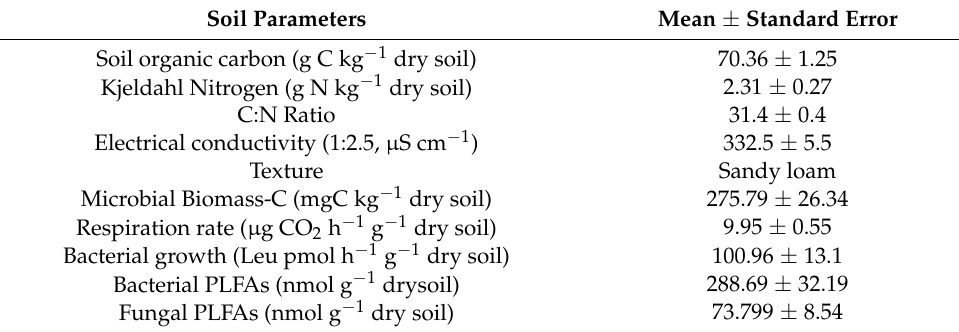
Table 2. Results of soil characterization of the samples collected in the unaltered high mountain shrubs ecosystem before laboratory heating and the preparation of different culture media (mean value ± standard